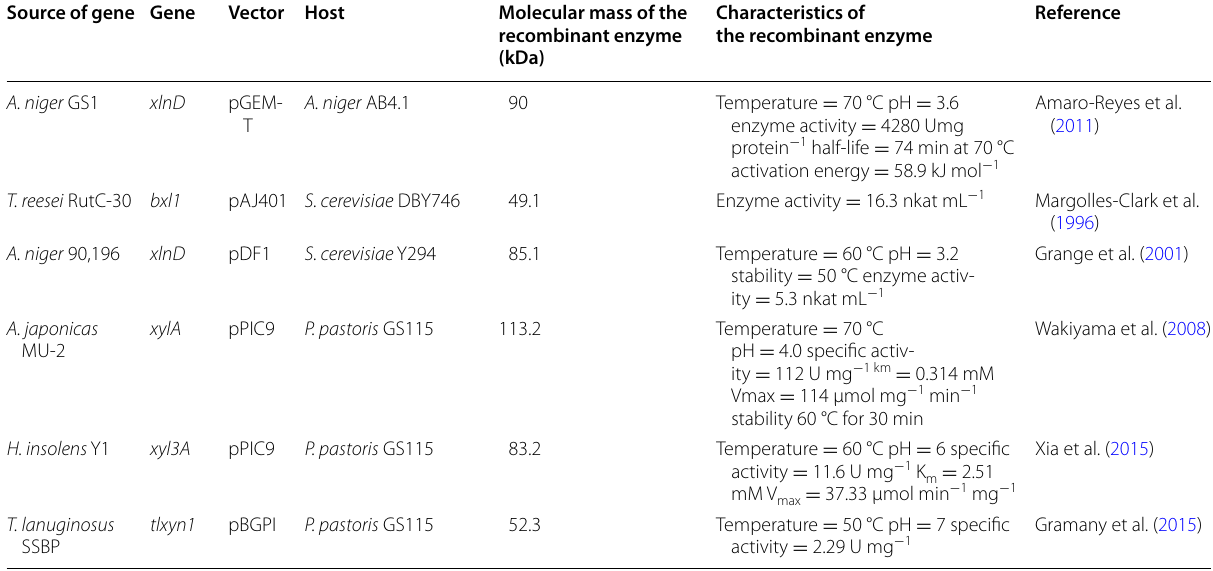
Table 3 Cloning of different fungal β‑Xylosidase genes in fungi Source of gene